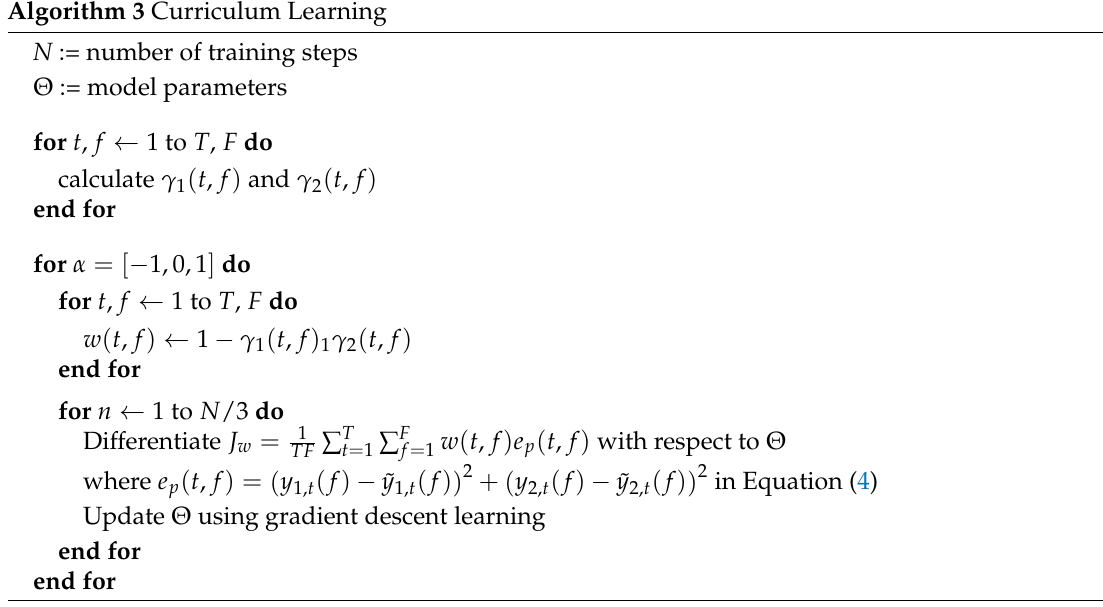
Algorithm 3 Curriculum